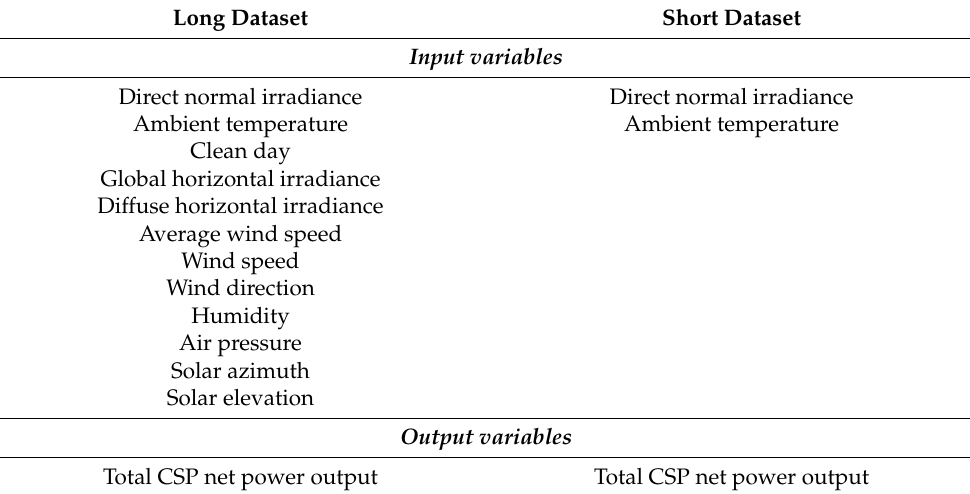
Table 6. Input and output variables of datasets implemented in both MLP and RBF neural network